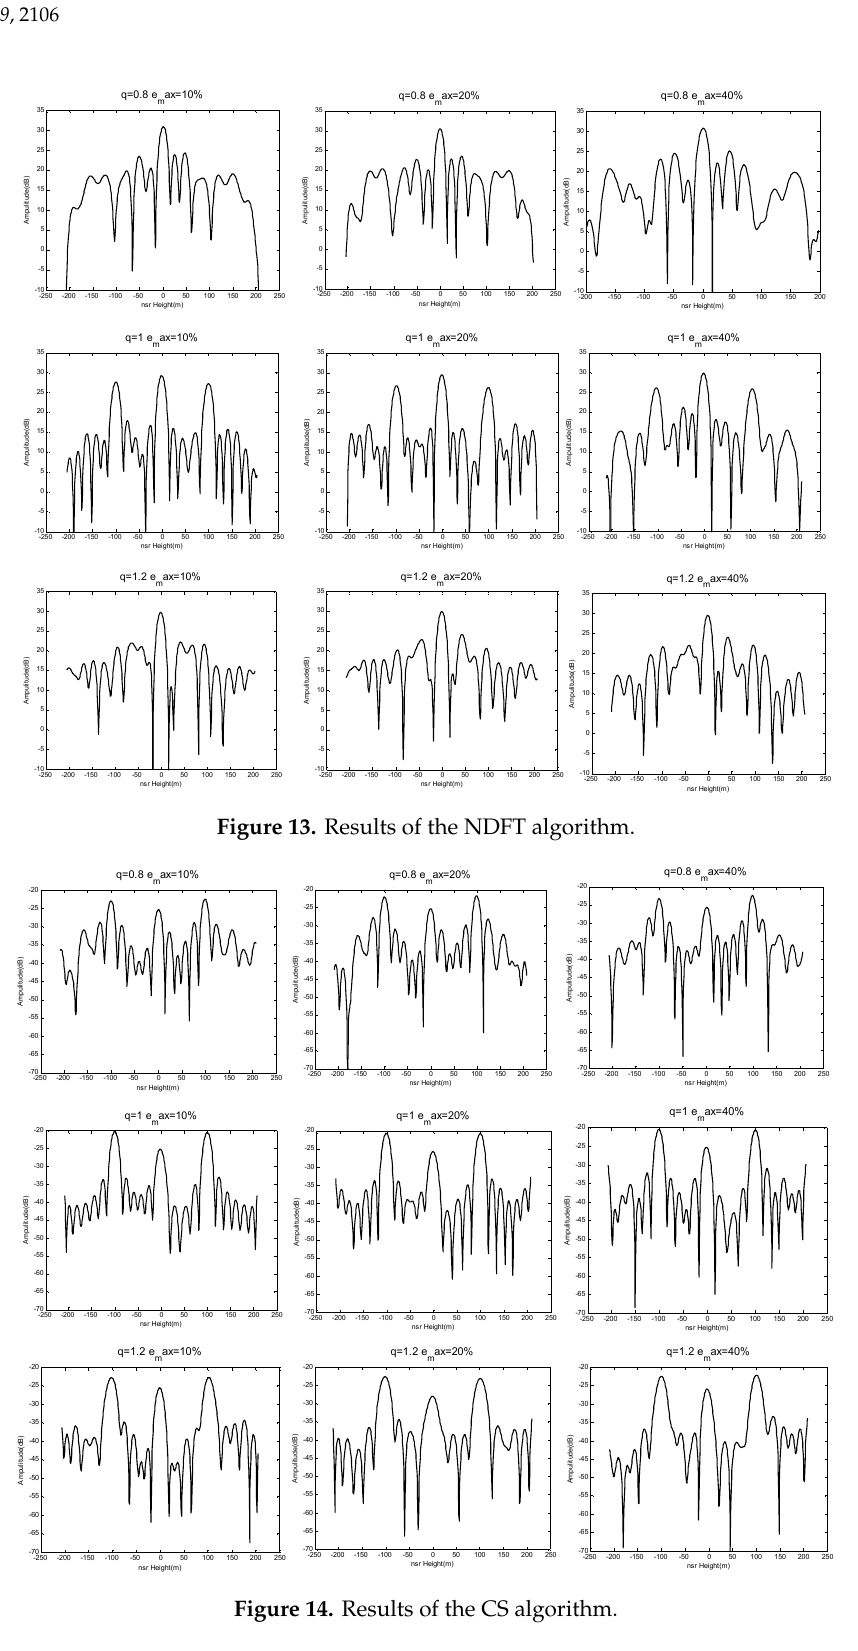
Figure 14. Results of the CS algorithm.